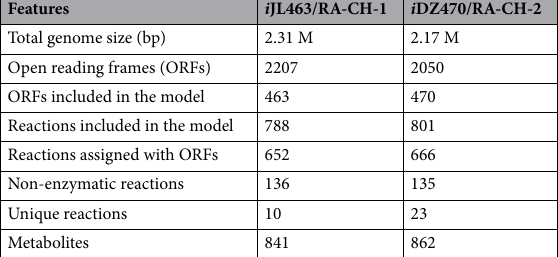
Table 2. Features of the genome and genome-scale metabolic model in RA-CH-1 and RA-CH-2.